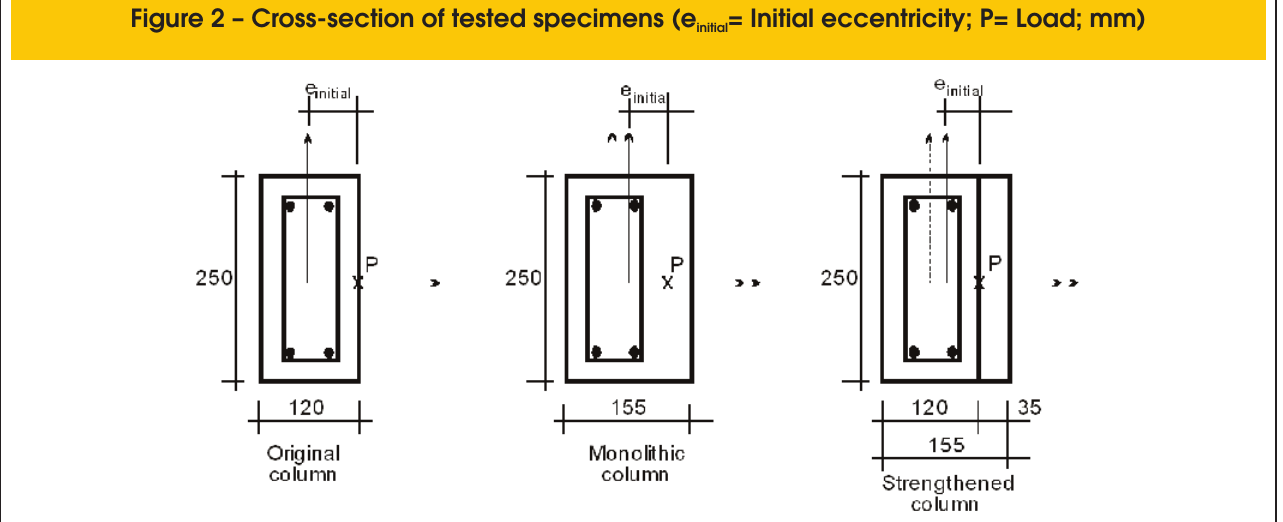
Figure 2 – Cross-section of tested specimens (e = Initial eccentricity; P= Load; mm)